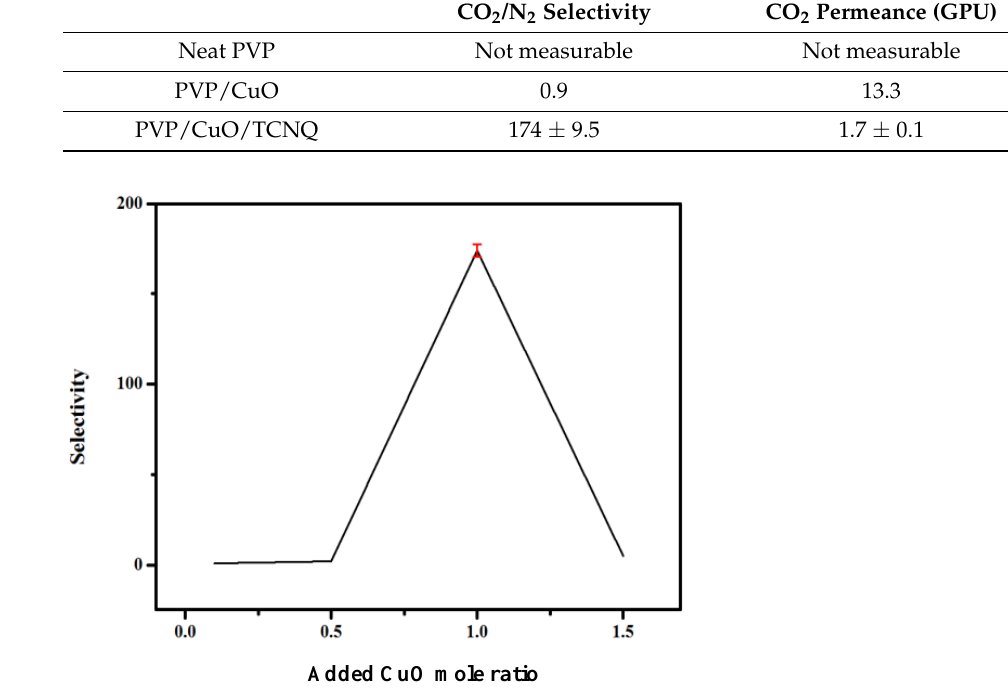
Figure 8. CO 2 /N 2 separation performance of PVP/CuO/TCNQ membrane according to CuO.